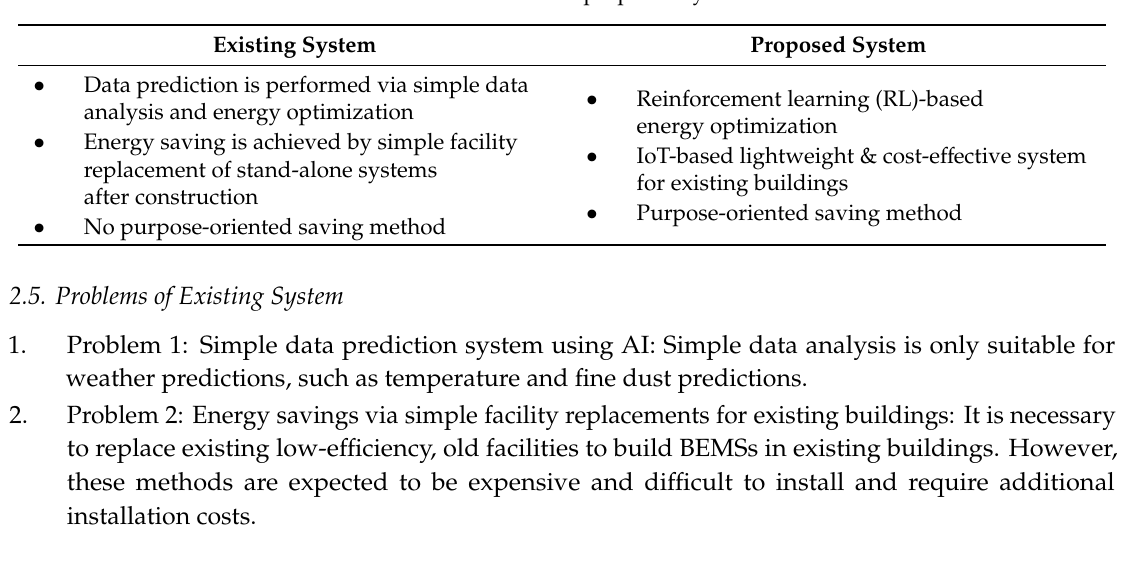
Table 1. Merits of the proposed